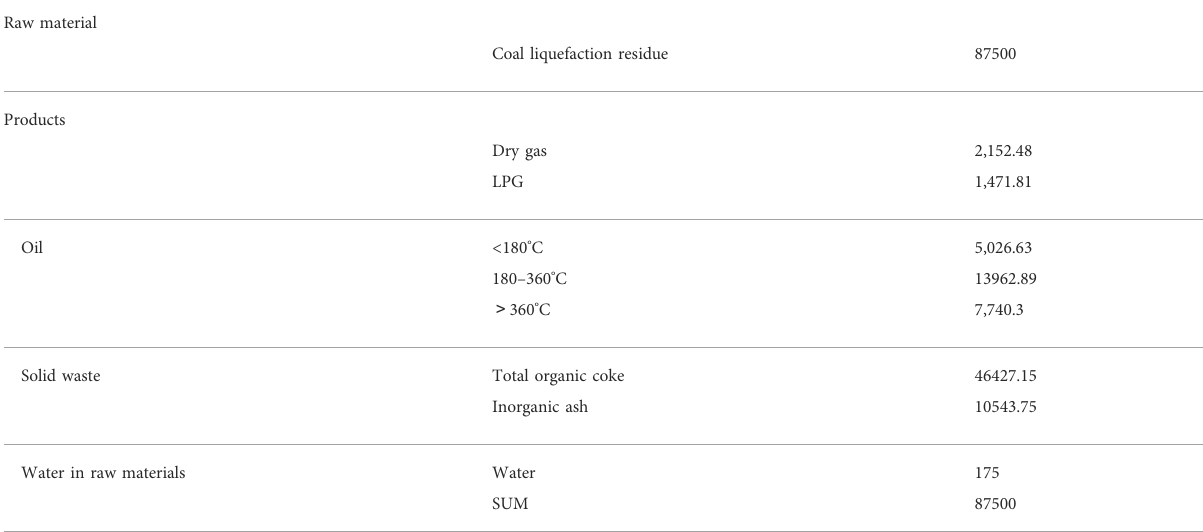
TABLE 3 Material balance of reaction part of the fl uidized